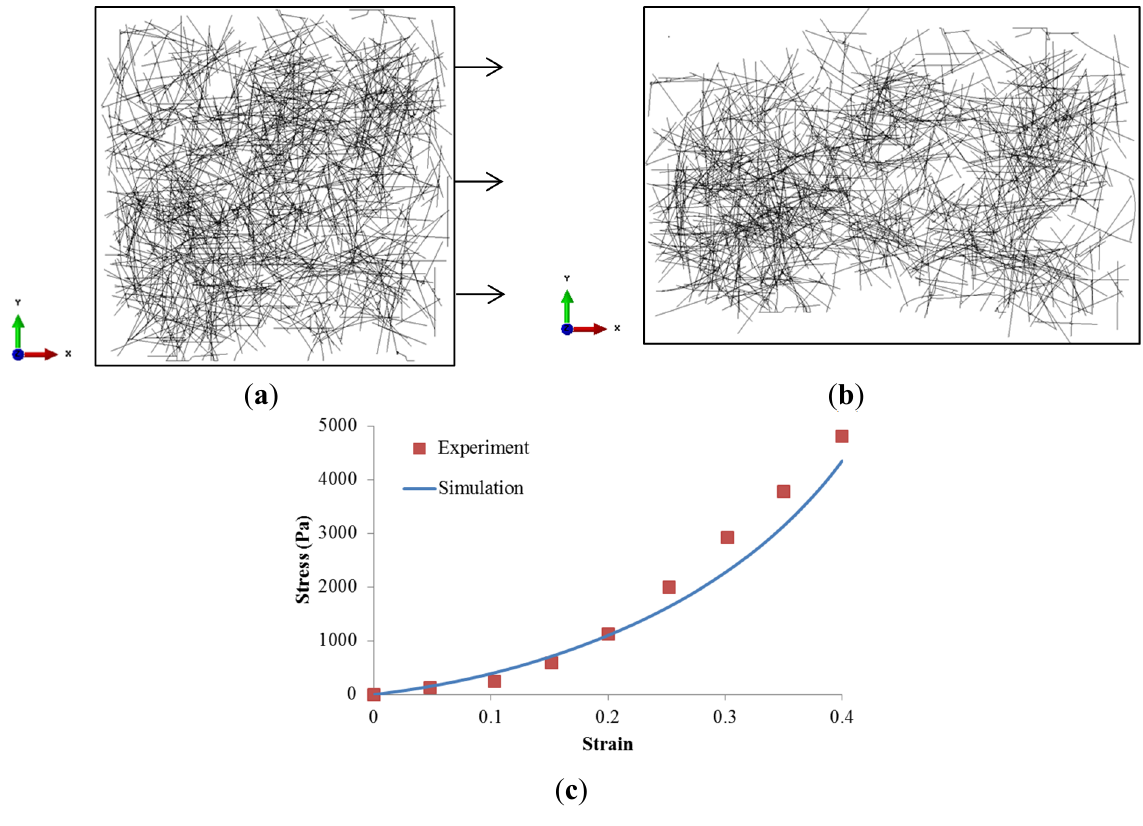
Figure 2. Cross-linked collagen fiber network ( a ) at zero loading; ( b ) at 40% strain along x -direction; and ( c ) stress–strain